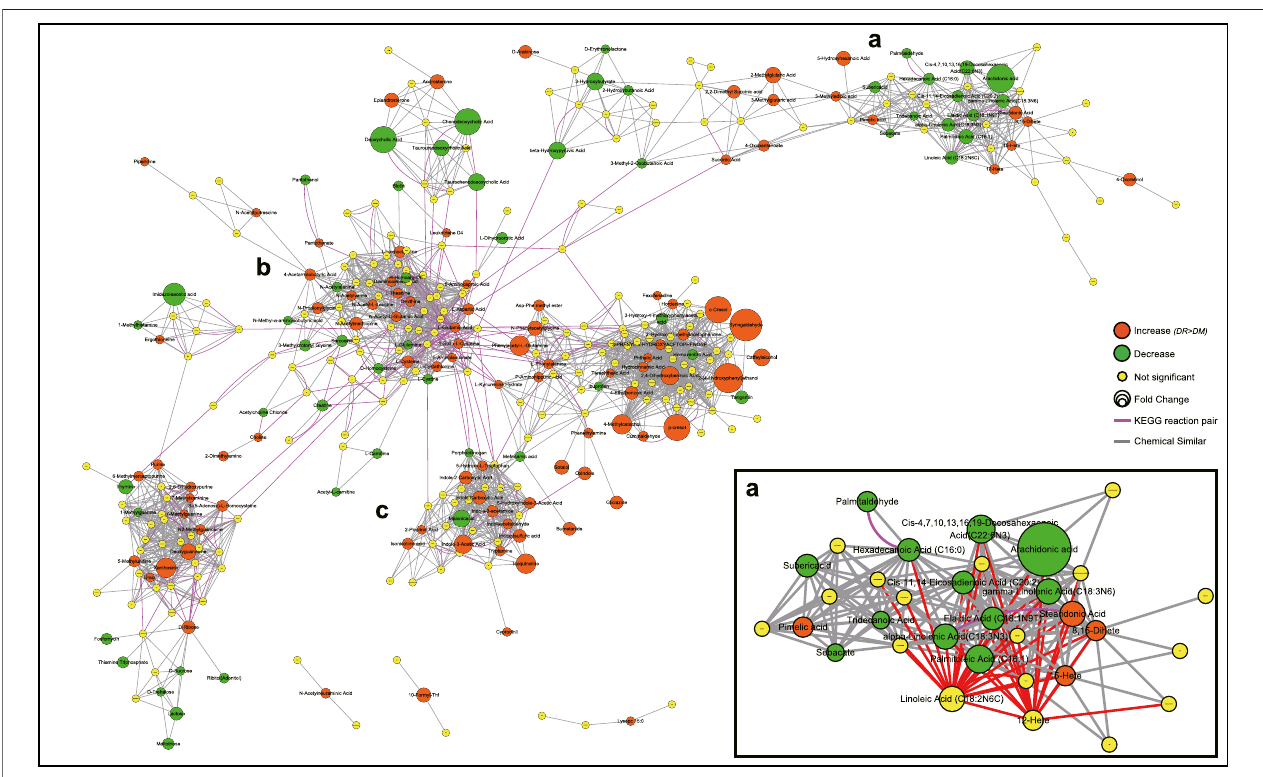
FIGURE 4 | Metabolic network visualizing by MetaMapp. Orange nodes indicate increased metabolites in DR patients compared to DM patients, while the green nodes indicate a decrease. Node size indicates the magnitude of fold change. Purple edges denote KEGG reactant pair links, and grey edges symbolize Tanimoto chemical similarity over 700. Module a mainly includes PUFAs and their derivatives, module b mainly includes amino acids, module c includes indole and its derivatives. Abbreviations: DR, type 2 diabetes mellitus (T2DM) with diabetic retinopathy; DM, T2DM without diabetic retinopathy; KEGG, Kyoto Encyclopedia of Genes and Genomes